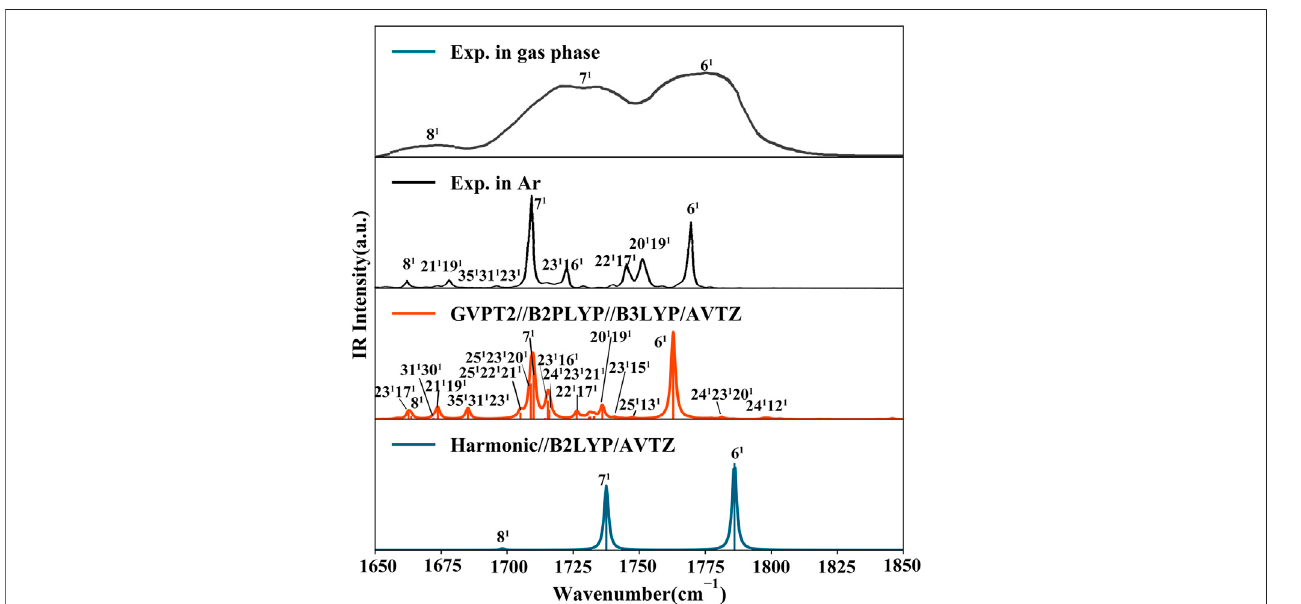
FIGURE 5 | IR spectrum of thymine in the CO stretching range (1650 cm − 1 - 1850 cm − 1 ). Computed stick spectra were broadened by Lorentzian functions with half width at half-maximum (HWHM) of 1 cm − 1 . Most signi fi cant contributions to intense bands are assigned as m n where m is the normal mode and n is the number of quanta on this mode (1 fundamentals, 2 overtones). Experimental spectra of gas phase thymine (Colarusso et al., 1997) and of Ar low temperature matrix trapped thymine (Szczepaniak et al., 2000) are shown for comparison.